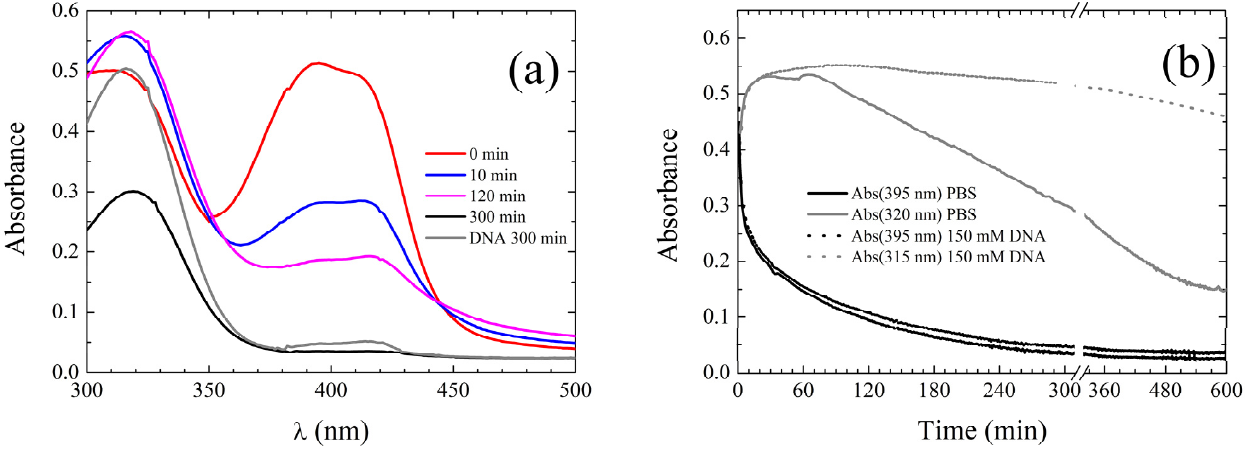
Figure 4. ( a ) Selected absorption spectra during a time-lapse experiment aimed at monitoring hydration dynamics of 1 preliminarily dissolved in DMSO; ( b ) absorbance at selected wavelengths versus time in the same experiment. See text for details.